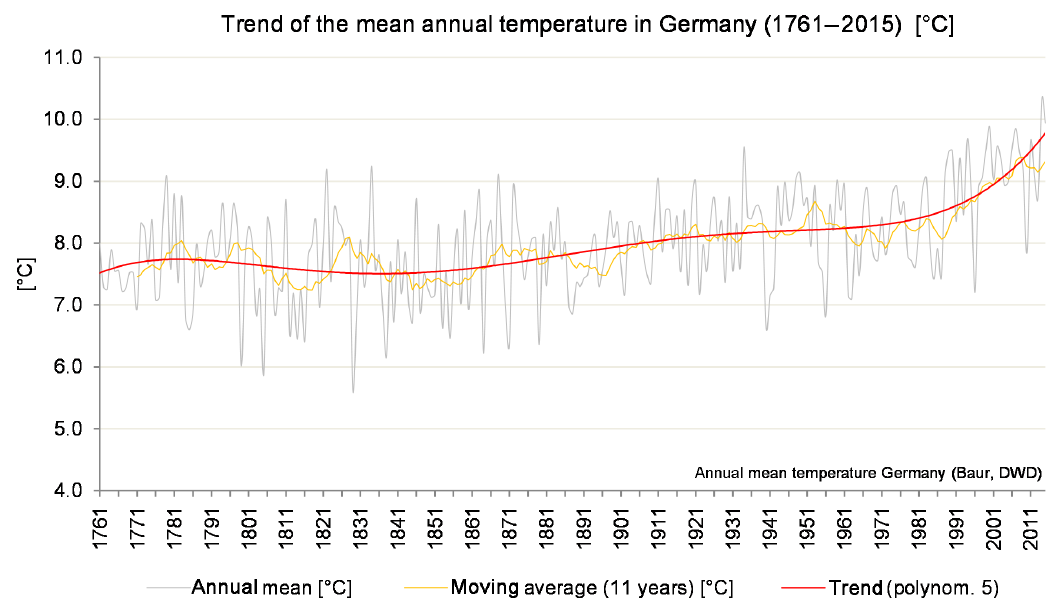
Figure 6. Evolution of the mean annual temperature in Germany (area average according to Baur and